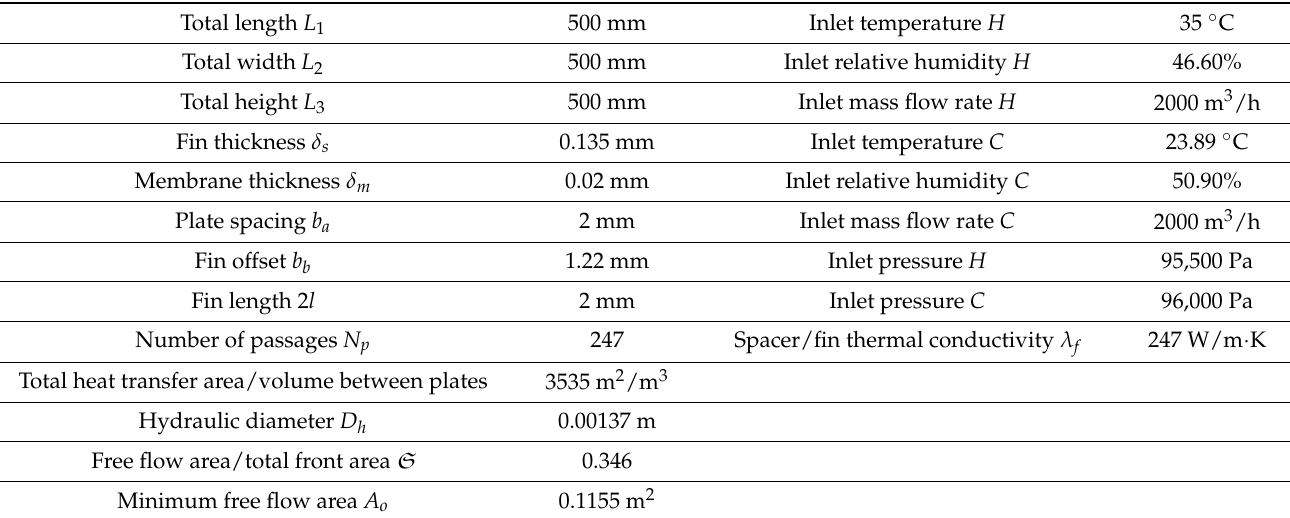
Table 4. Exchanger core characteristics and operating